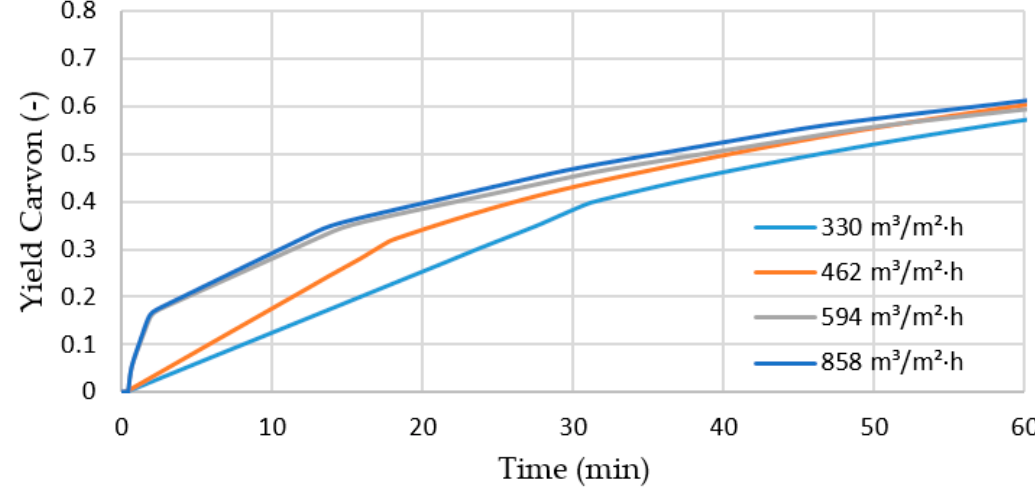
Figure 21. Model-based optimization of distillation by flow rate adaptation, shown as gas load.